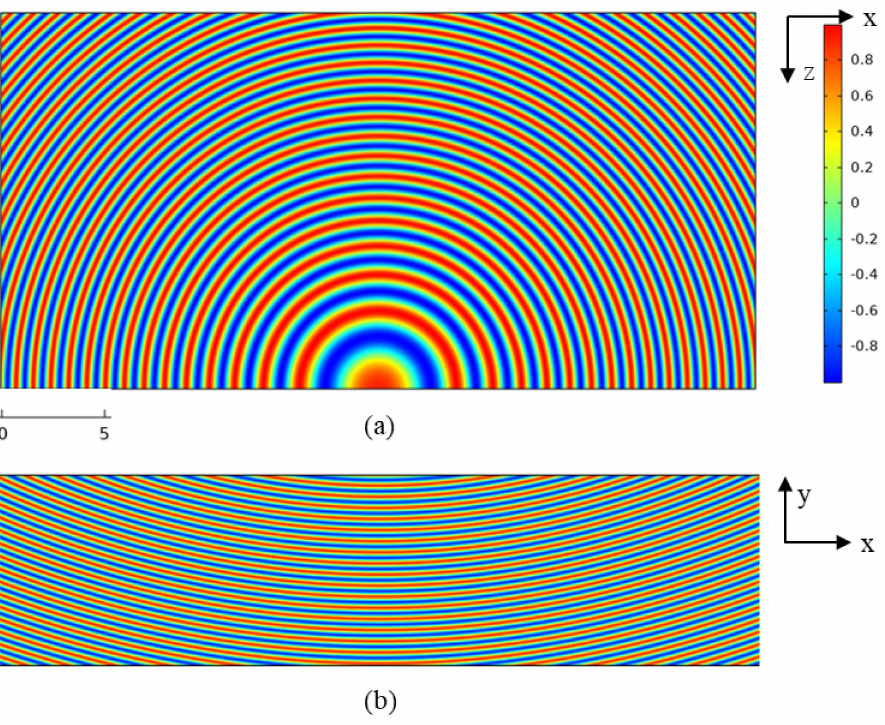
Figure 1. ( a ) a section view of the PVL optical axis phase(sin α ) in x − z plane. ( b ) a section view of the PVL optical axis phase(sin α ) in x − y plane.